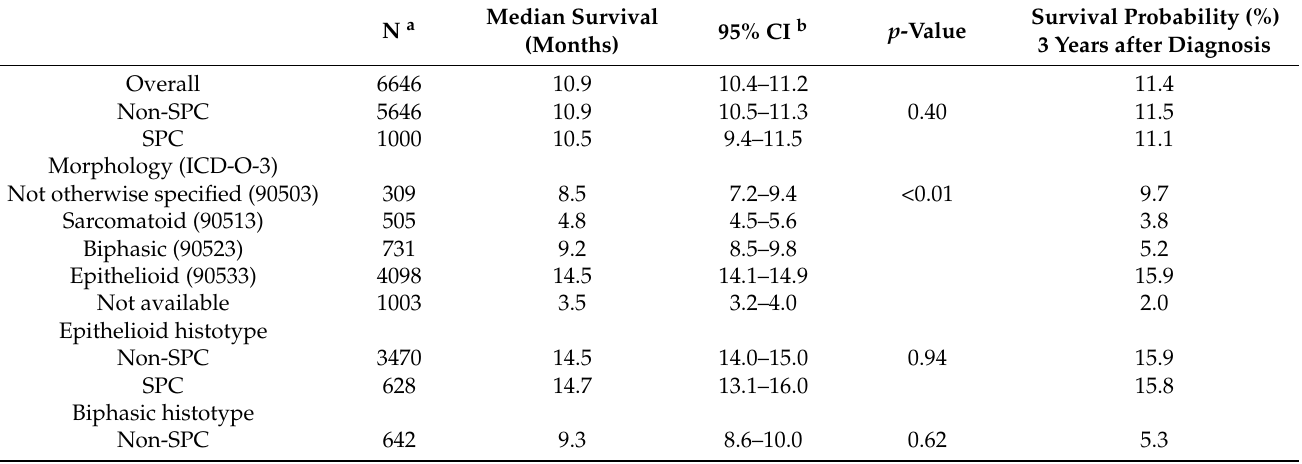
Figure 3. Overall survival by second primary cancer (SPC) estimated using Kaplan–Meier curve, Lombardy, 2000–2018. Follow-up period 2000–2021. Table 5. Overall survival by second primary cancers (SPC), histotype, and by SPC/histotype jointly, Lombardy 2000–2018. Follow-up period